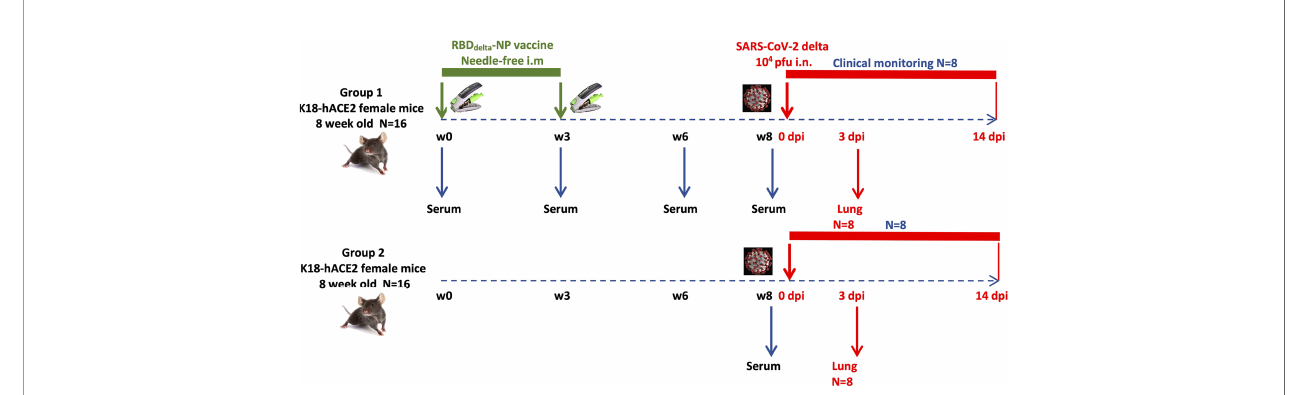
FIGURE 4 | Experimental design of immunogenicity and protection ef fi cacy study of mRNA RBD Delta -NP vaccine in K18-hACE2 transgenic mice: Two groups (n=16): Group 1 immunized with mRNA RBD Delta -NP vaccine, Group 2 unvaccinated control. In each group 8 mice are sacri fi ced at 3 dpi for lung collection and 8 mice are followed for clinical signs until 14